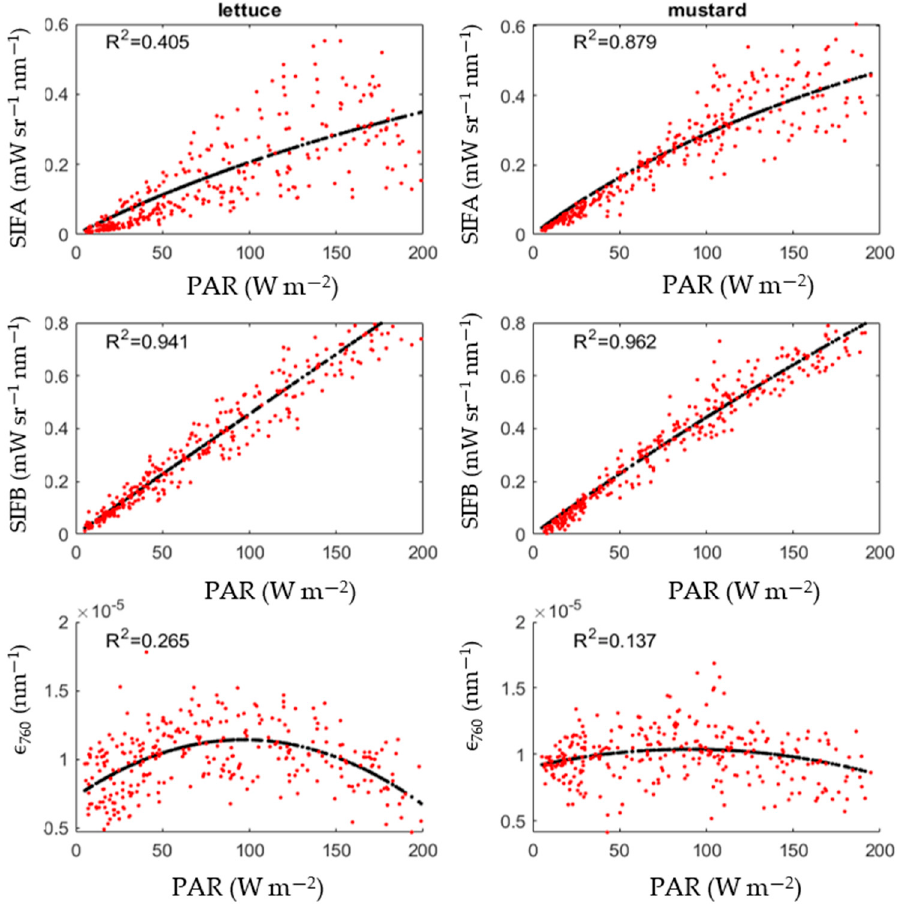
Figure 7. Fitted (black lines) and observed (red dots) values of SIFA, SIFB and ϵ 760 in function of PAR.